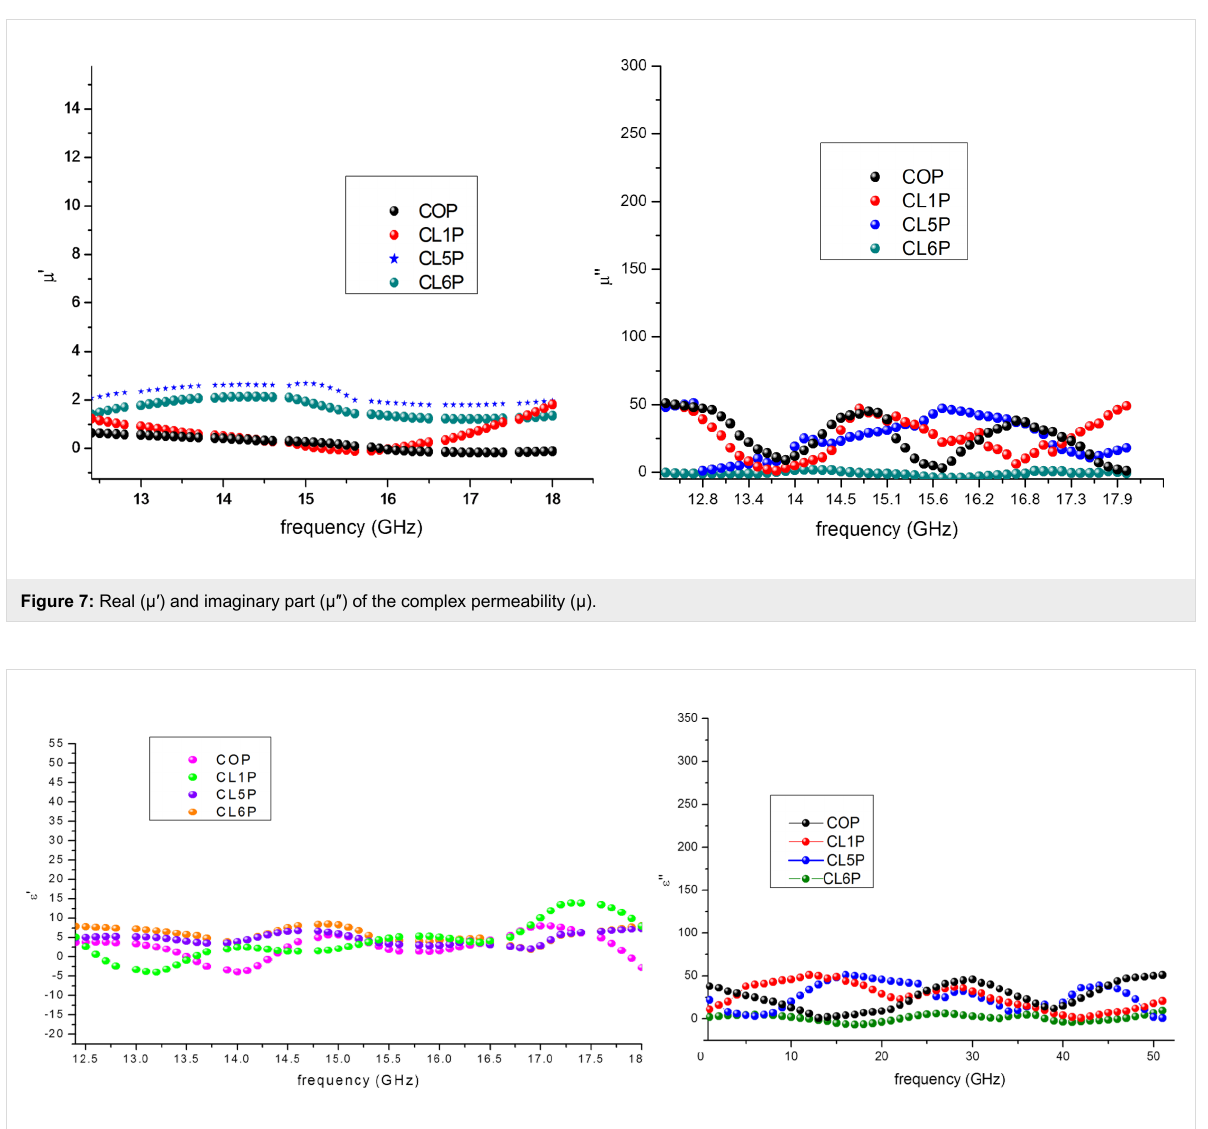
Figure 8: Real ( ε′ ) and imaginary part ( ε″ ) of the complex permeability ( ε ).